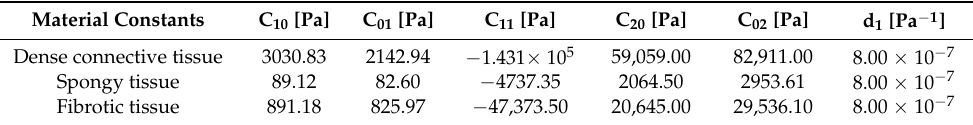
Table 1. Material constants for the 5-parameters Mooney–Rivlin material model. Material Constants Dense connective